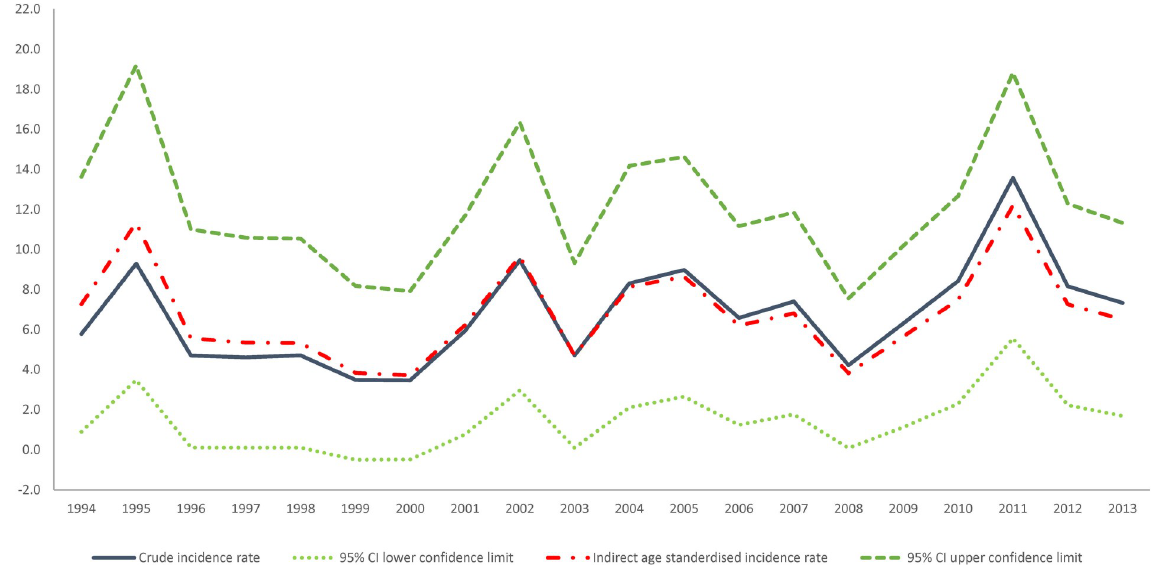
Fig 2. Crude, indirect age-standardized incidence rate with upper and lower limits for 95%CI of the indirect age-standardized incidence rate of breast cancer diagnosis during pregnancy in NSW 1994–2013 per 100,000 women giving birth.